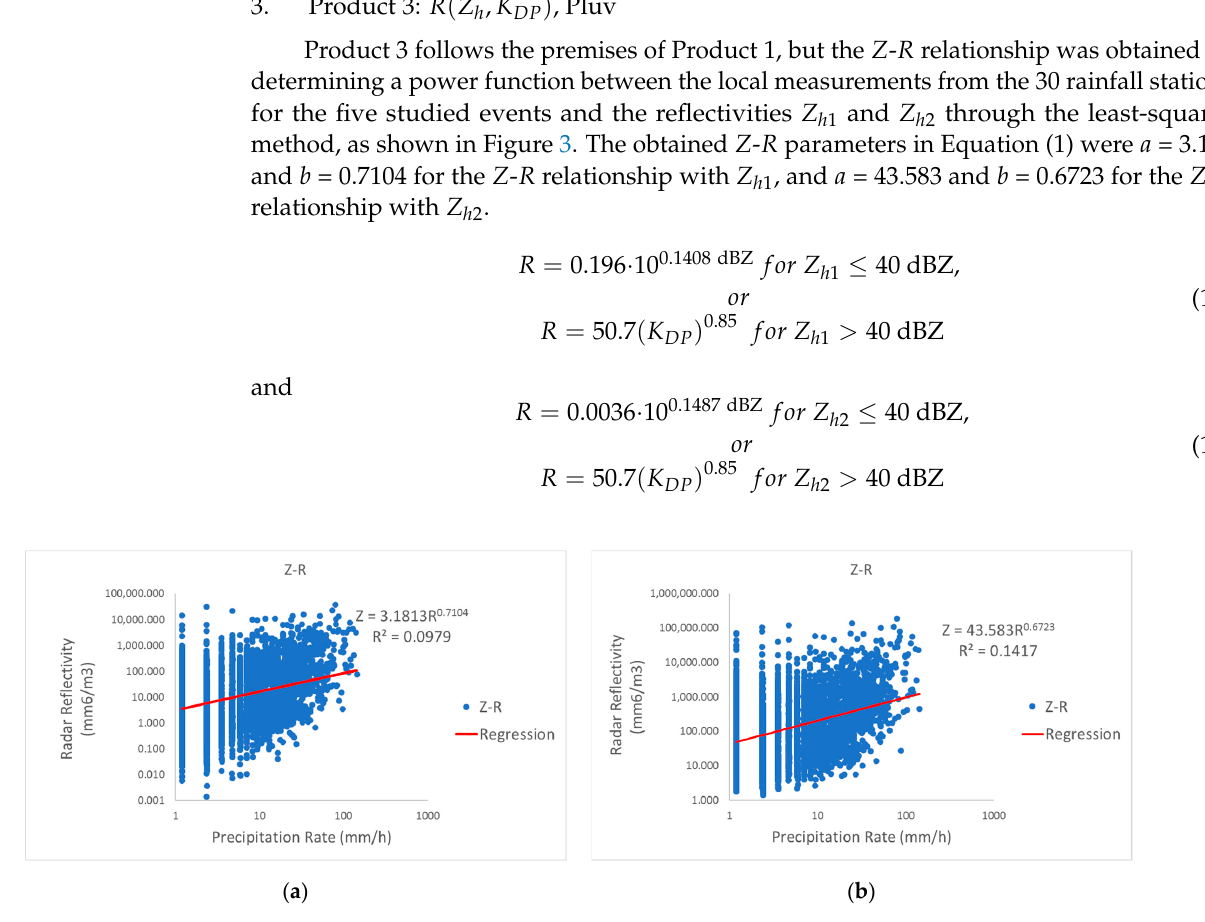
Figure 3. Different regressions developed in this work between Guaratiba’s S-band radar data and rain gauge measurements: ( a ) method of least squares applied to Z h 1 (radar reflectivity without ZPHI-method correction); ( b ) method of least squares applied to Z h 2 (radar reflectivity corrected by ZPHI